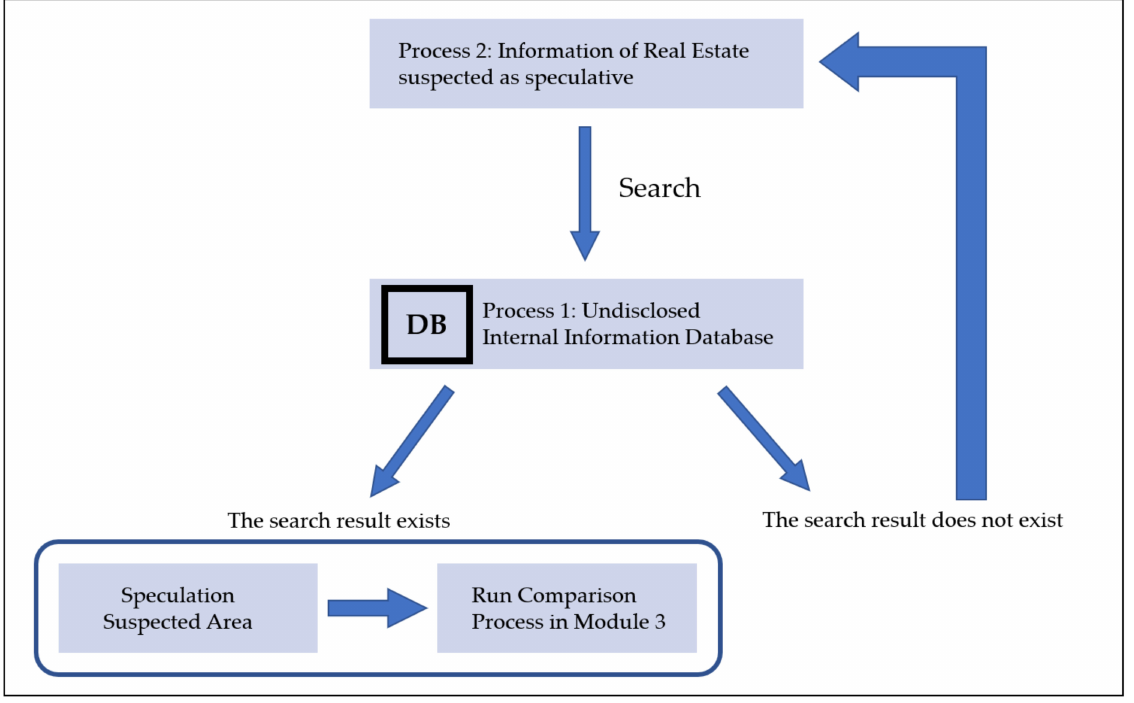
Figure 6. The Process of Confirming